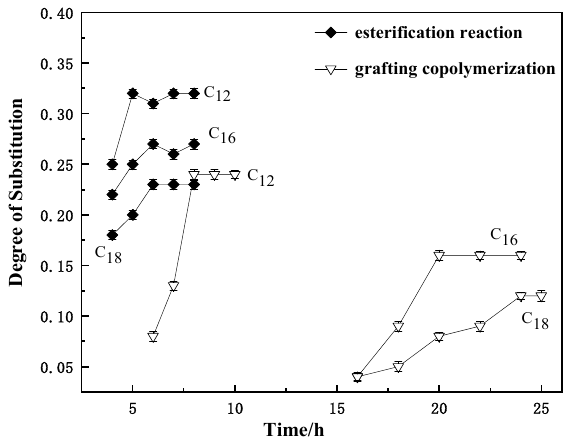
Figure 3. Effect of reaction time on substitution degree of MCNC.